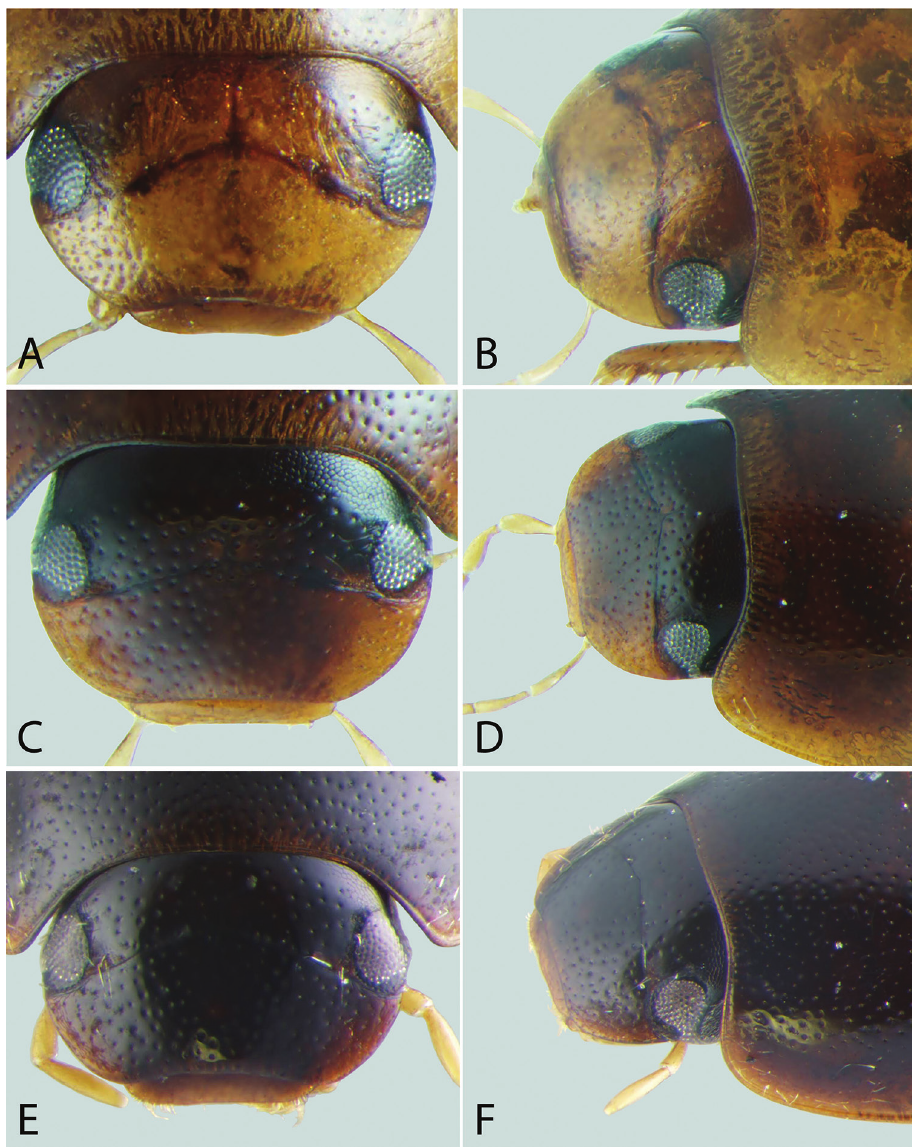
Figure 6. Front and lateral view of heads of Tobochares spp. A–B T. pallidus sp. n. C–D T. canthus sp. n. E–F T. emarginatus sp.